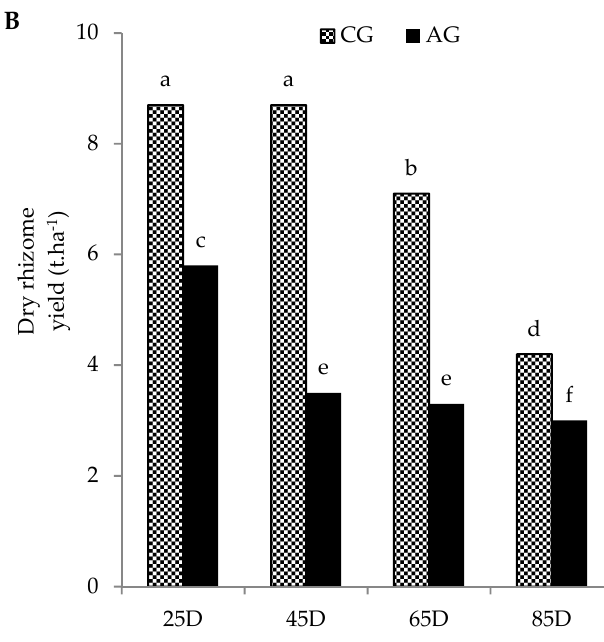
Figure 9. Dry rhizome yield (t ha − 1 ) of African ginger in response to irrigation regimes during the ( A ) 2015/2016 and ( B ) 2016/2017 cropping seasons. Mean values followed by the same letter in the same bars are not significantly different at ( p ≤ 0.05) level according to the Tukey’s test. Where: CG: Commercial ginger; AG: African ginger; Lsd = 0.3 and 0.2 for Figure A and B respectively.